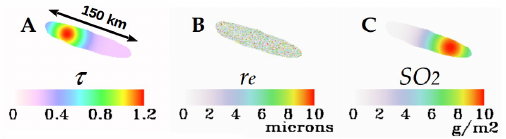
Figure 1: Volcanic cloud configuration. t (plate A), r e (plate B) and SO 2 (plate